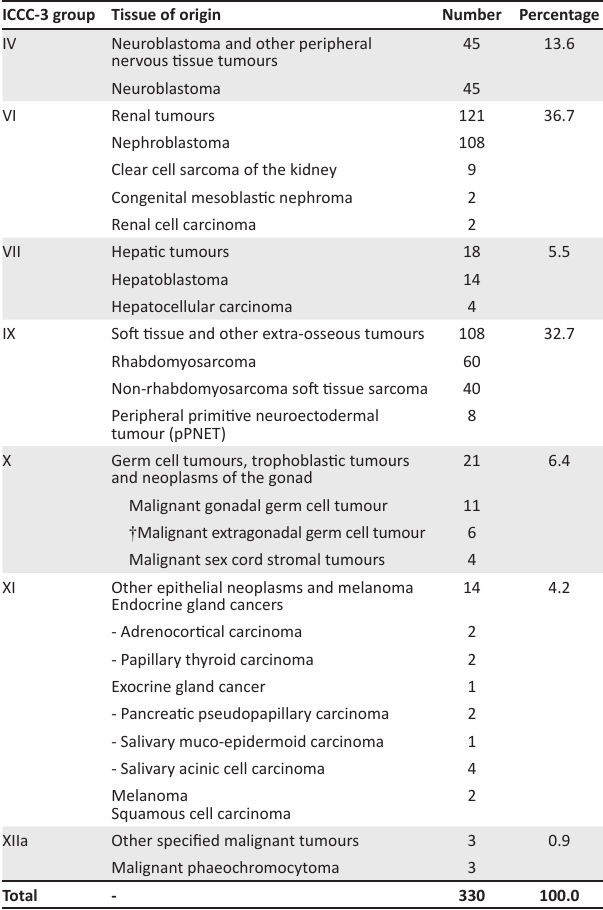
TABLE 1: Relative frequencies of malignant tumours according to the ICCC-3 classification. ICCC-3 group Tissue of